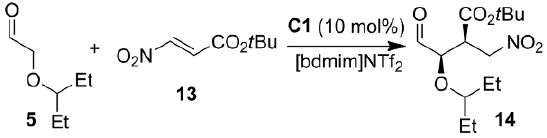
Table 5. Michael addition of 5 with 13 in [bdmim]NTf